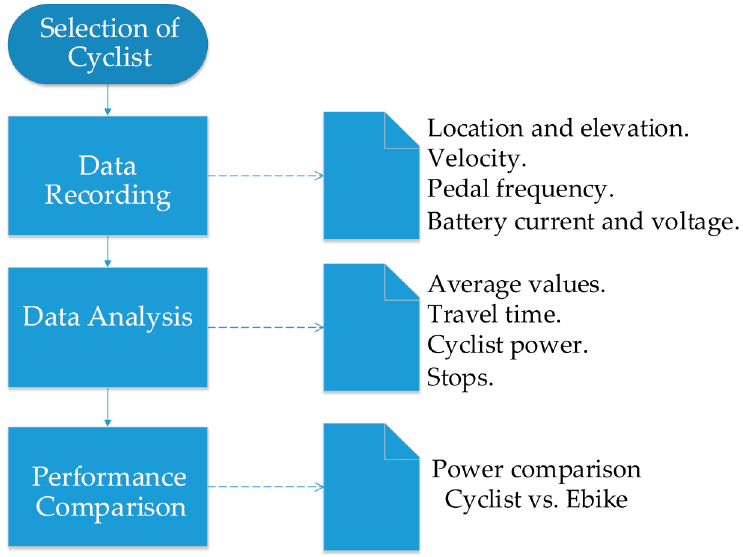
Figure 2. Methodology to quantify Bogota City bike users’ requirements.